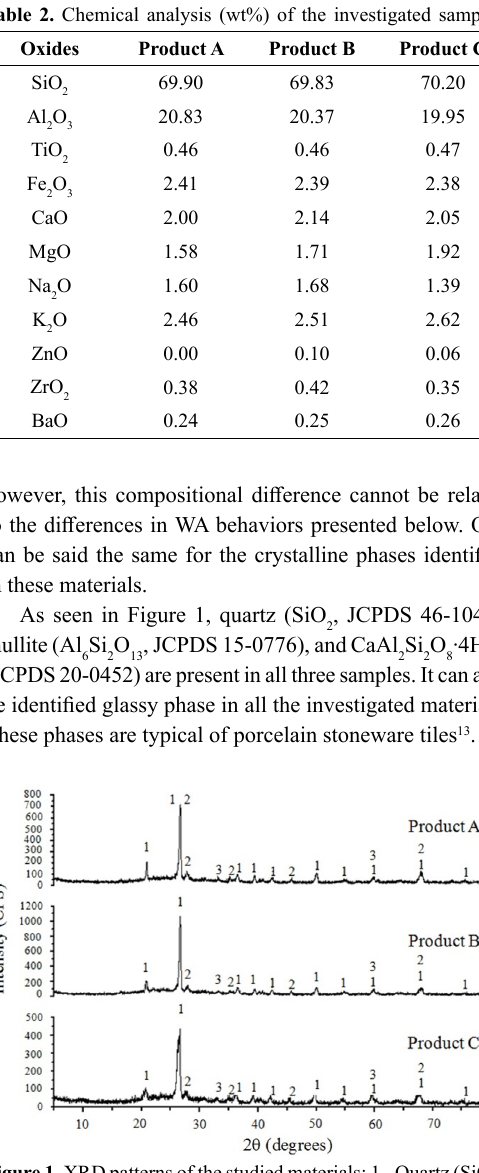
Figure 1. XRD patterns of the studied materials: 1 - Quartz (SiO 2 - Mullite (Al